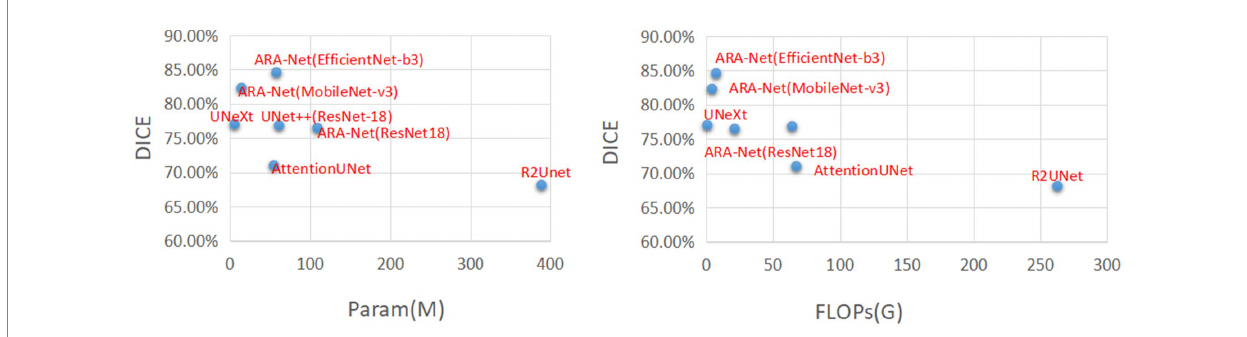
FIGURE 4 Comparison charts. X -axis corresponds to FLOPs(G) and the number of parameters (lower the better). Y -axis corresponds to DICE (higher the better).